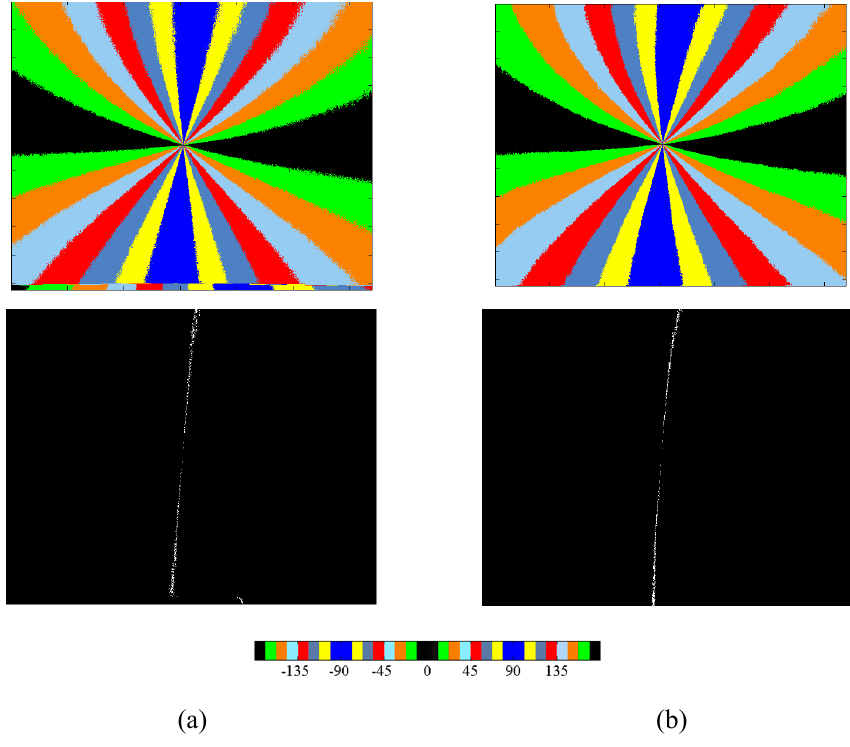
Figure 6. ( a ) AoE and BSM images calculated from the calibrated intensity images; and ( b ) AoE and BSM images calculated from the original intensity images.